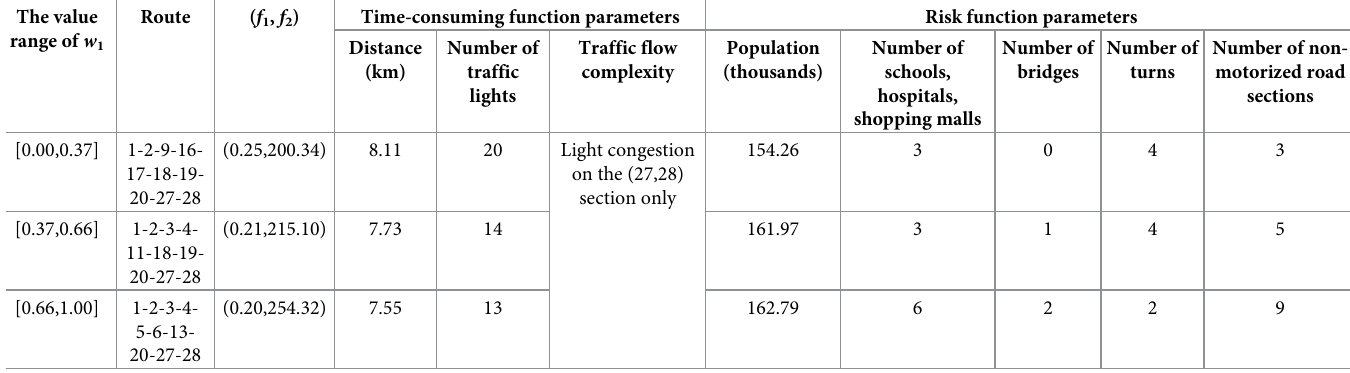
1. The model has the function of transportation vehicle path optimization. Given the user a time-consuming preference coefficient, a preferred route can be obtained. And through the simulation analysis, the preference coefficient changes in a certain range, corresponding to the same route, that path selection is not sensitive to the change of preference coefficient in a certain range. In the meantime, in dealing with multi-objective problems, different from the direct assignment of coefficient method, the model reveals the response relationship between user preference and path selection by adjusting the time-consuming preference coefficient, and replaces the fixed value with the interval range, which is more realistic [49]. In this case, when choosing the safest route, Route 1, the time-consuming preference coeffi- cient range is the largest, about 0.37, while the minimum range is about 0.29 when Route 2 is chosen to compromise time-consuming and safety. Moreover, when Route 2 is selected, the interval ranges of time-consuming and safety preference coefficients are 0.37~0.66 and 0.34~0.63, respectively, indicating that when this route is selected, the coefficients of time- consuming and safety preference can reach 0.66 and 0.63 at the same time.